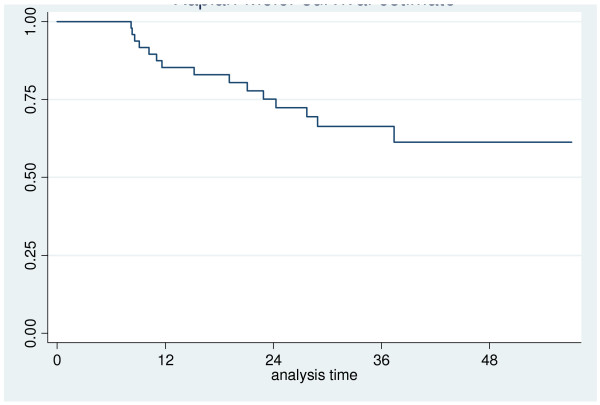
Overall survival.